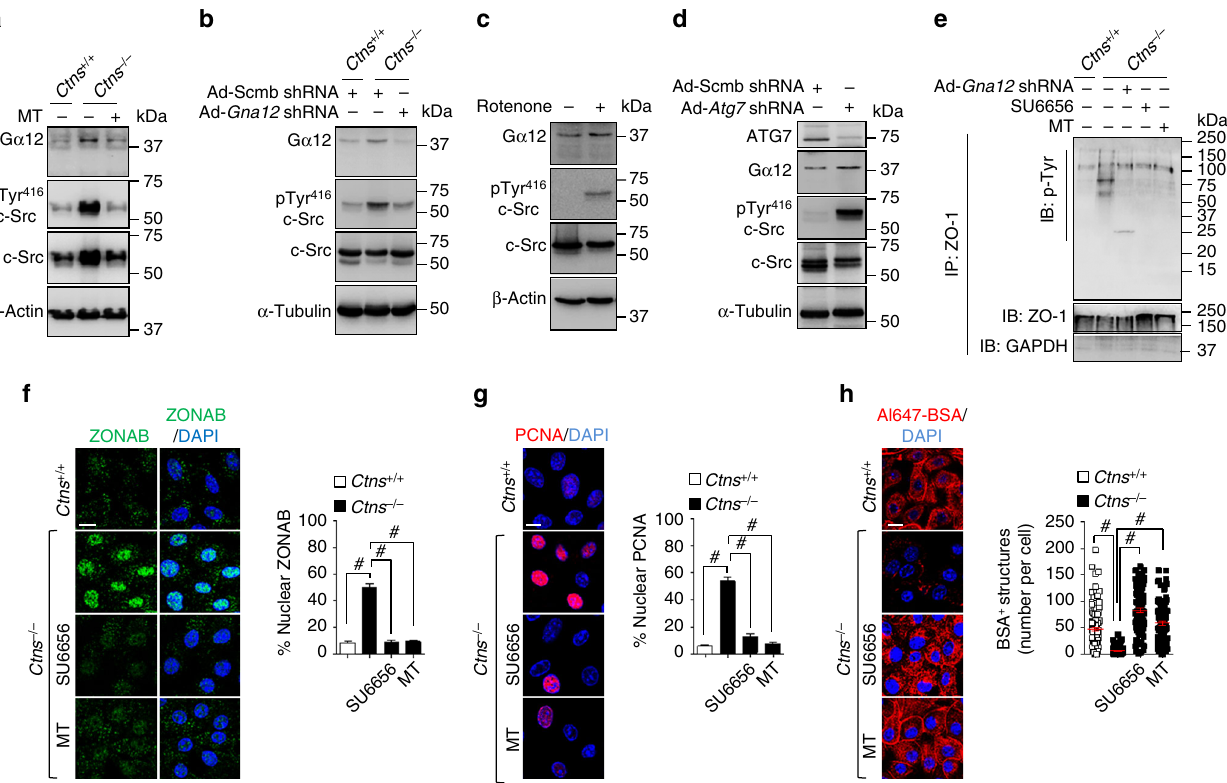
Fig. 8 Mitochondrial ROS triggers Ga12/Src-mediated destabilization of ZO-1. a Representative western blotting of G α 12, pTyr 416 c-Src, and c-Src protein levels in Ctns mPTCs treated with or without the mitochondria-targeted antioxidant Mito-TEMPO (MT, 10 μ M for 24 h). β -Actin was used as a loading control, n = 3 independent experiments. b Representative western blotting of G α 12, pTyr 416 c-Src, and c-Src protein levels in Ctns mPTC transduced with either Scmb or Gna12 adenoviral shRNAs for 5 days. α -Tubulin used as a loading control, n = 2 independent experiments. c Representative western blotting of G α 12, pTyr 416 c-Src, and c-Src protein levels in mPTCs treated with Rotenone (250 nM for 8 h) or d transduced with Scmb or Atg7 adenoviral shRNAs for 5 days. In c and d , β -Actin and α -Tubulin were used as a loading control, n = 3 independent experiments. e Tight junction ZO-1 protein was immunoprecipitated from Ctns + / + or Ctns − / − mPTCs and from Ctns − / − mPTCs transduced with Ad- Gna12 shRNA or treated with either mitochondria- targeted antioxidant Mito-Tempo (MT, 10 μ M for 24 h) or with a selective Src-kinase inhibitor SU6656 (5 μ M for 24 h) and the phosphorylation rate was examined by western blotting. f – h Ctns mPTCs were treated with either mitochondria-targeted antioxidant MitoTempo (MT, 10 μ M for 24 h) or a selective Src-kinase inhibitor SU6656 (5 μ M for 24 h). f Ctns mPTCs were immunostained with anti-ZONAB (green) antibody and imaged by confocal microscopy. Quanti fi cation of ZONAB + nuclei (in percentage of the total nuclei) was obtained from fi ve randomly selected fi elds per condition, with each containing ~ 20 – 25 cells. g Ctns mPTCs were immunostained with anti-PCNA antibody and imaged by confocal microscopy. Quanti fi cation of PCNA + nuclei (in percentage of the total nuclei) obtained from fi ve randomly selected fi elds per condition, with each containing ~ 20 – 25 cells. h The cells were loaded with Al647-BSA (50 μ g ml − 1 for 15 min at 37 °C) and imaged by confocal microscopy. Quanti fi cation of numbers of Al647-BSA + structures ( n = 100 cells pooled from three mouse kidneys per condition; each point representing the number of BSA + structures in a cell). One-way ANOVA followed by Bonferroni ’ s post hoc test, # P < 0.0001 relative to Ctns + / + mPTCs or to untreated Ctns − / − mPTCs. Plotted data are mean ± SEM. The nuclei are counterstained with DAPI (blue). The scale bars are 10 μ